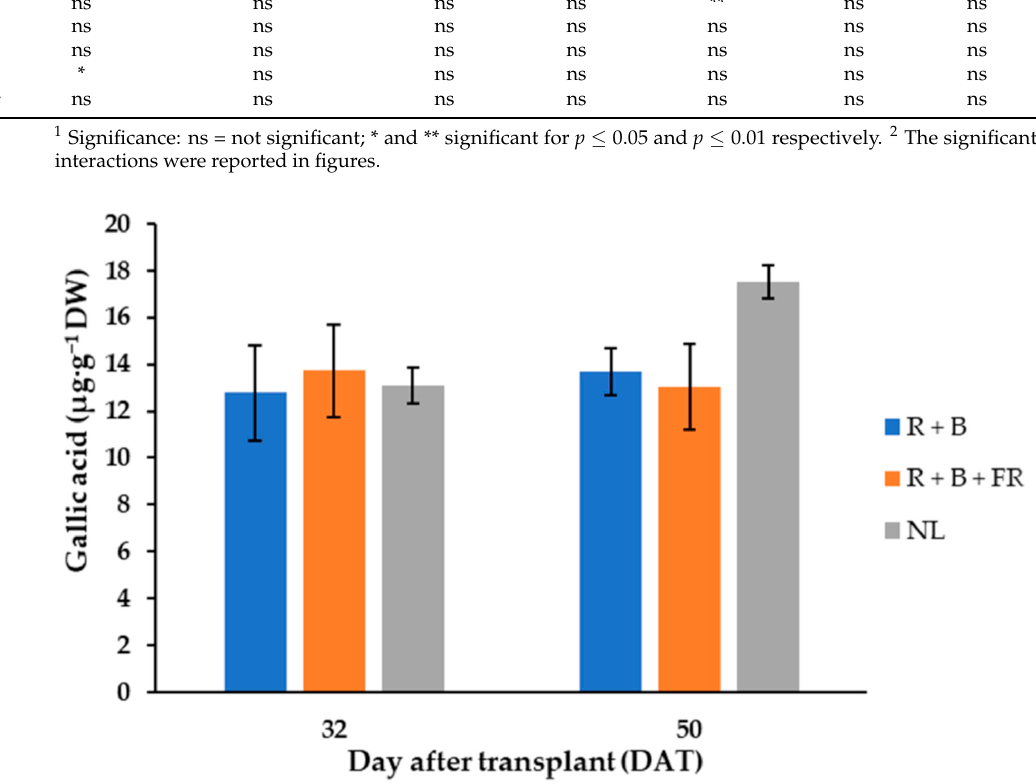
Table 1. Effects of the day of harvest and light treatments on the polyphenols profile of the fruits of like p -coumaric was found for chlorogenic acid, especially for the fruits harvested 32 DAT a landrace of Cucumis melo L. (“Carosello leccese”). Values are the average ± DS of three replications. (Table 1). For these fruits, the content of chlorogenic acid was 14.4% higher than for the fruits harvested 50 DAT. Rutin was the least abundant phenolic compound identified,